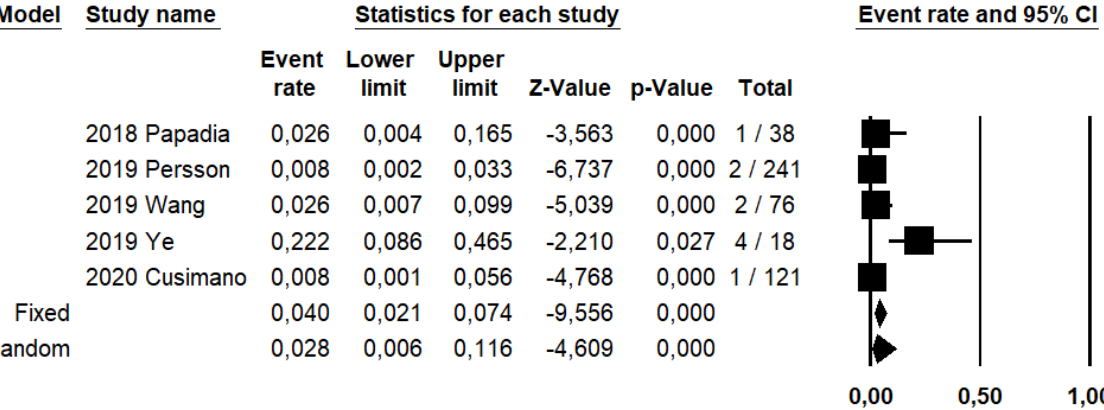
Figure 2. Forest plots of individual studies and pooled false negative rate of sentinel lymph node biopsy in detecting endometrial carcinoma metastasis.